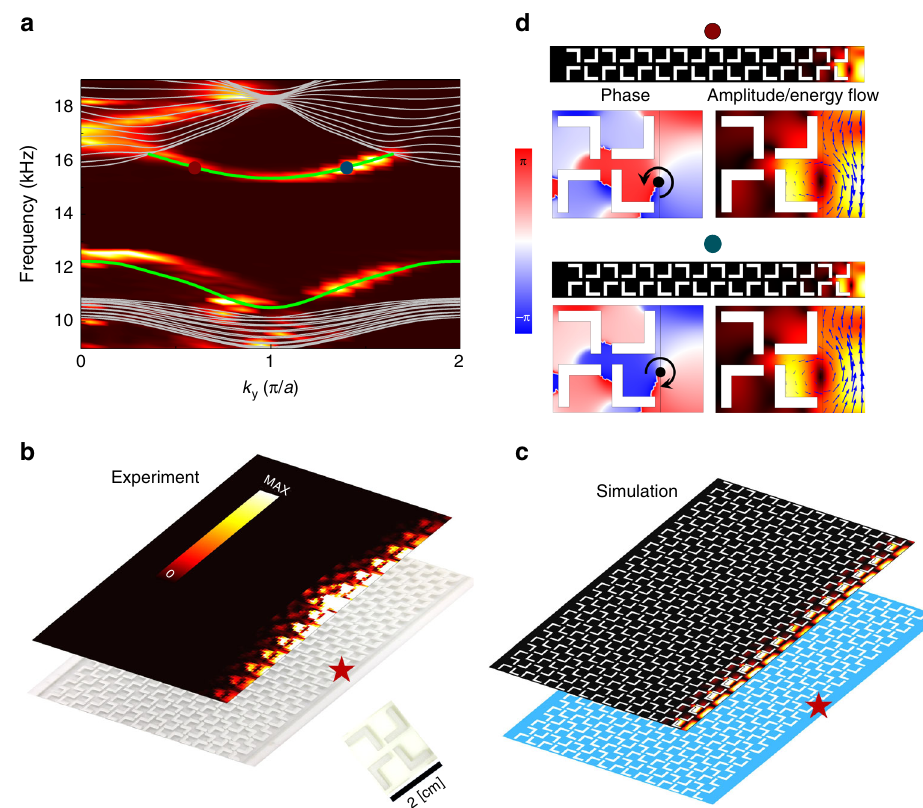
Fig. 3 Gapped topological edge states induced by anomalous quadrupole in the second band gap. a Measured (hot color) and calculated (green) dispersions of the acoustic edge states. Gray curves represent calculated acoustic bulk bands. b , c Top: measured and simulated acoustic pressure pro fi les of the edge states launched by a point-like source (indicated by the red stars), respectively. Below: photo of the fabricated sample and the illustration of the structure, respectively. Inset in b : photo of a unit-cell. d Acoustic pressure pro fi les for the two edge states marked by the red and blue dots in a , with phase, amplitude and Poynting vectors (blue arrows) shown near the edge. Phase vortex centers and phase winding directions are marked by the black dots and arrows, respectively. The edge is formed between the sonic crystal and the hard-wall boundary made of photosensitive resin. Unit-cell geometry parameters are the same as that in Fig.